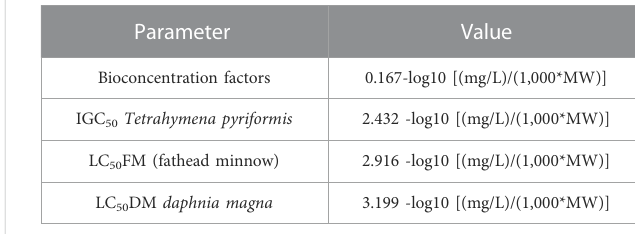
TABLE 5 Environmental toxicity of 4-hydroxyisoleucine calculated with ADMETLab